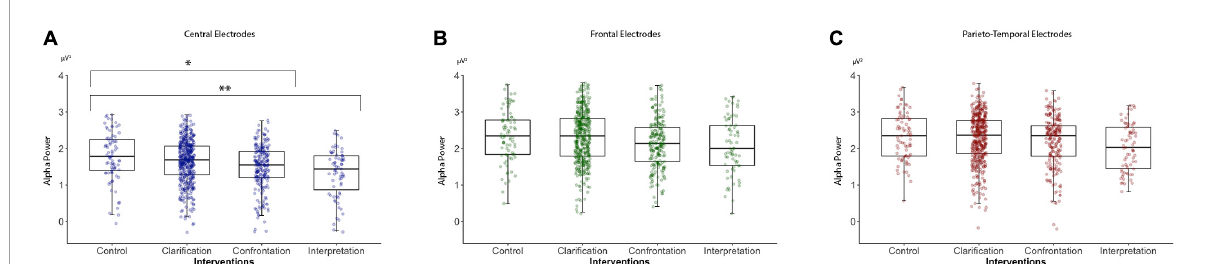
FIGURE2 Logarithms of alpha band power (8–12.5 Hz, µ V 2 ) in the central, frontal, and parieto-temporal electrodes of psychoanalytic intervention techniques (clarification, confrontation, and interpretation) and a control condition recorded during a structural psychoanalytic interview: (A) Alpha power in central electrodes, (B) alpha power in frontal electrodes, and (C) alpha power in the parieto-temporal electrodes. ∗ p < 0.05, ∗∗ p <